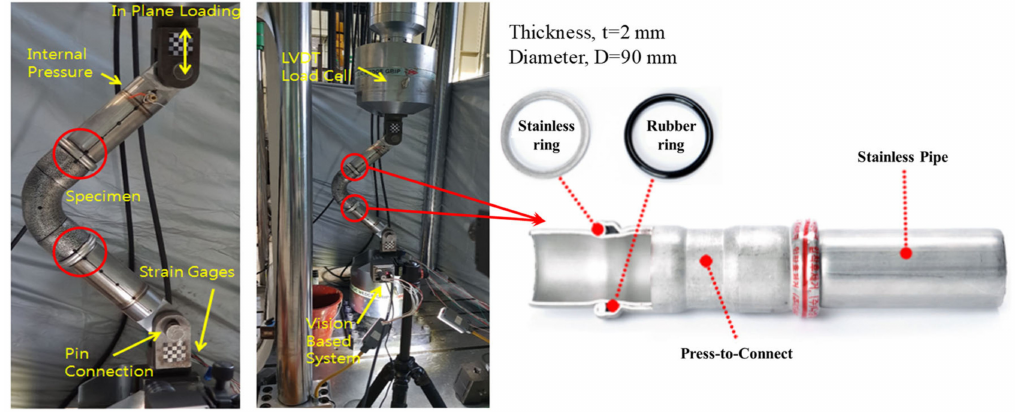
Figure 1. Experimental test of press-to-connect elbow system.